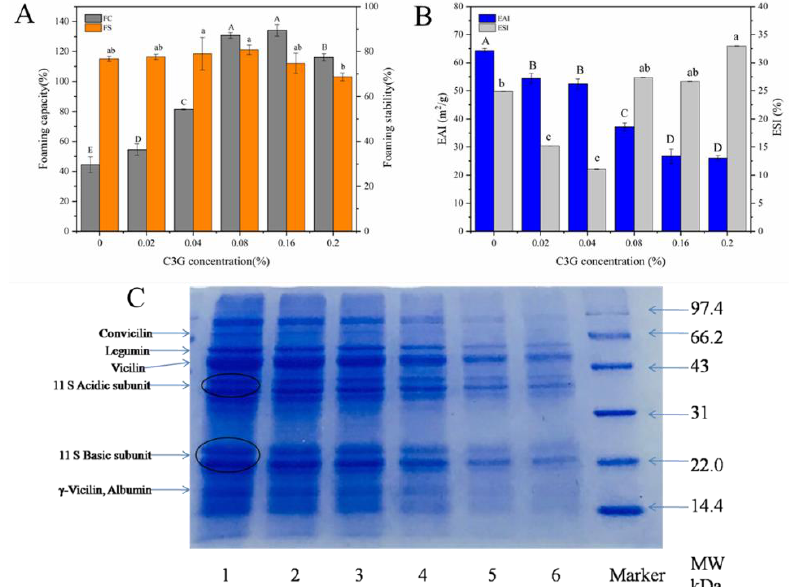
Figure 2. Foaming capacity and stability ( A ), emulsifying activity index (EAI) and emulsion stability index (ESI) ( B ), and SDS-PAGE profiles ( C ) of LPI-C3G complexes at different C3G concentrations. Lanes 1, 2, 3, 4, 5, and 6 represent C3G concentrations of 0, 0.02%, 0.04%, 0.08%, 0.16%, and 0.2%, respectively. Different letters represent significant differences ( p < 0.05).